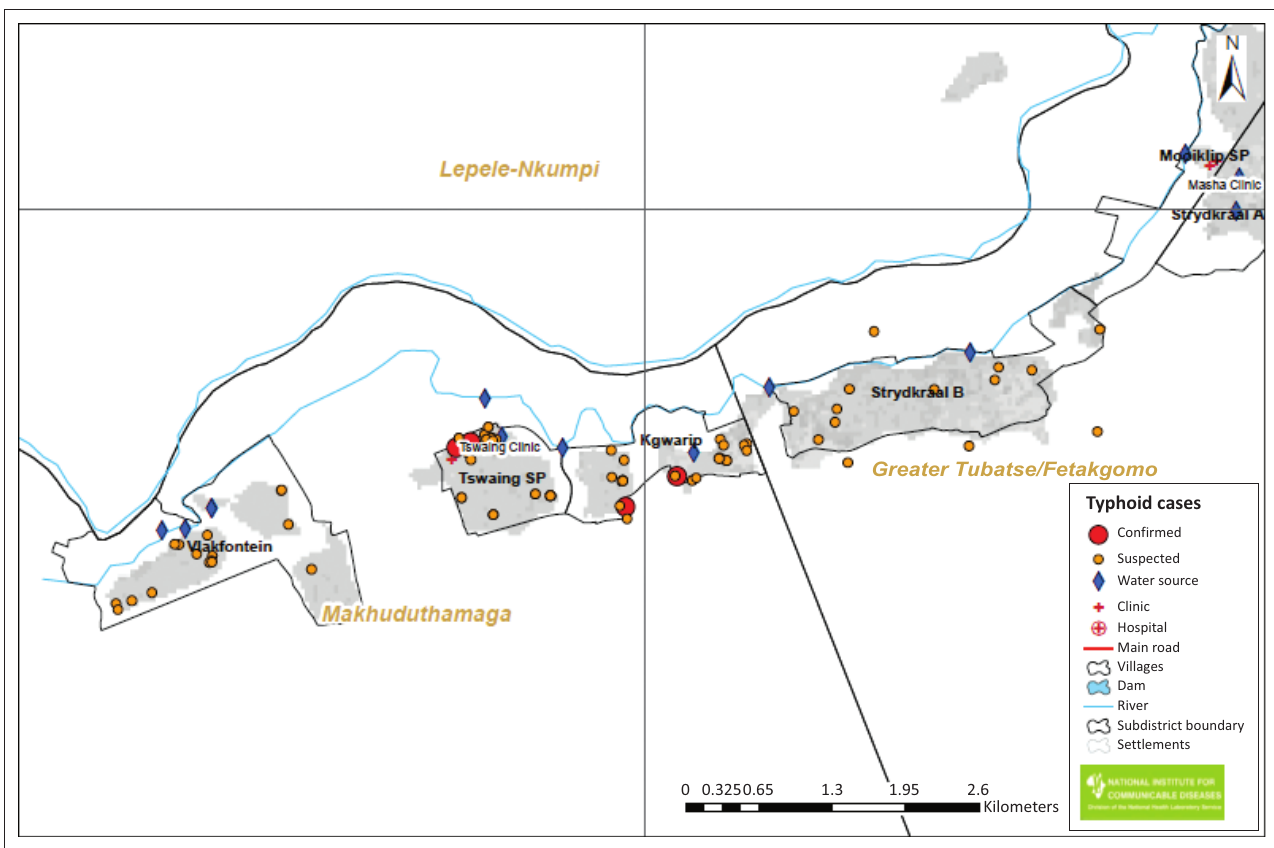
Source : Ramutshila TE, Mabotja MC, Makungo U, et al., Typhoid fever outbreak investigation in Sekhukhune district, Limpopo province, South Africa, November 2017 to January 2018, in National Institute for Communicable Diseases: Division of the National Health Laboratory Service, Public Health Surveillance Bulletin, 2018;16(3): 118–130, viewed n.d. from: https://www.nicd.ac.za/wp-content/uploads/2019/05/Volume-16-Issue-3-December-2018.pdf FIGURE 5: Geographic distribution of suspected and confirmed typhoid fever cases and water sources, Sekhukhune District, Limpopo province, November – December 2017.